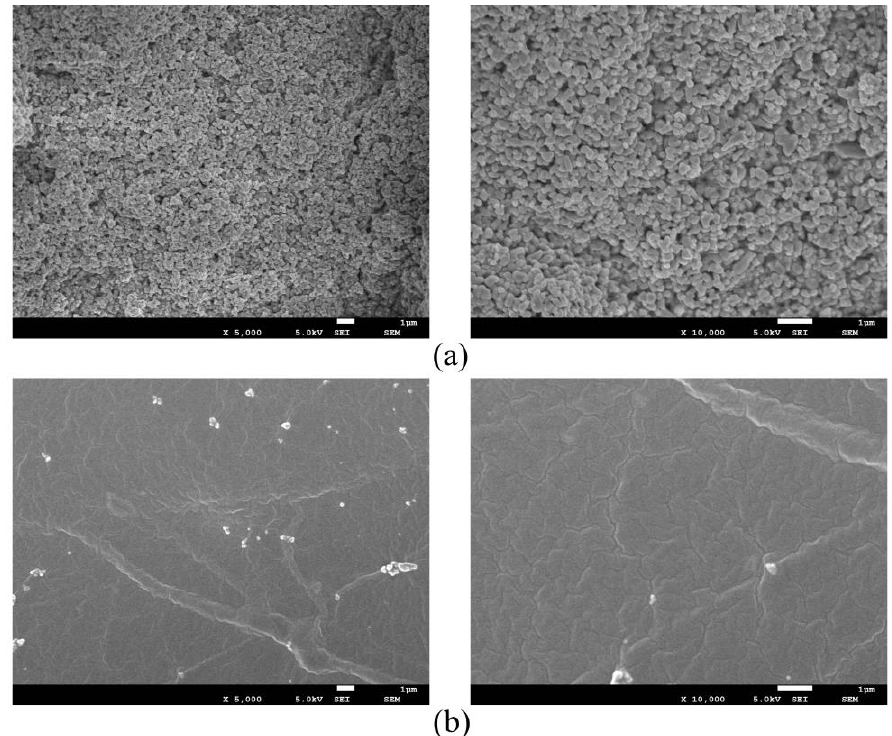
Figure 7. SEM test results: ( a ) SEM photo of PSC coating surface; ( b ) SEM photo of the waterborne polyurethane coating surface .